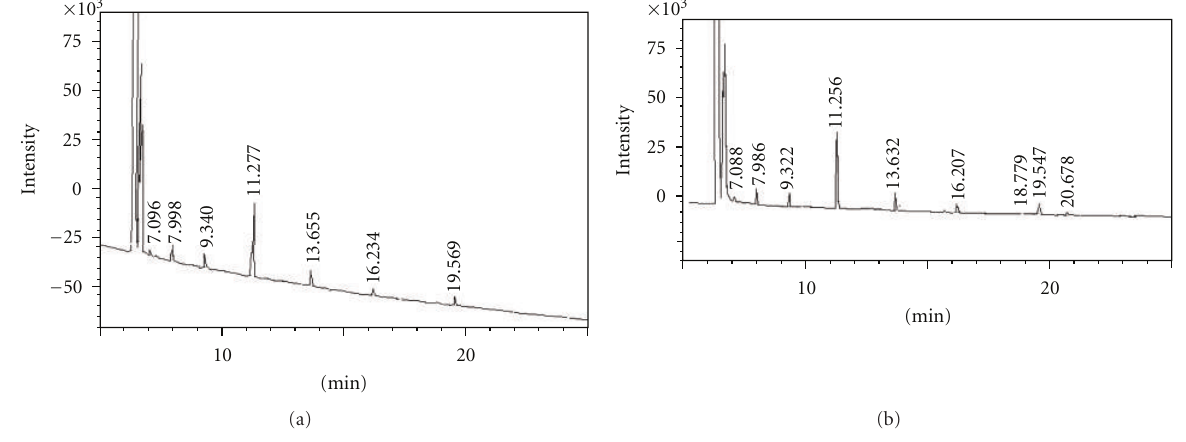
Figure 2: Fatty acid profiles of indai´a (a) and babassu (b)